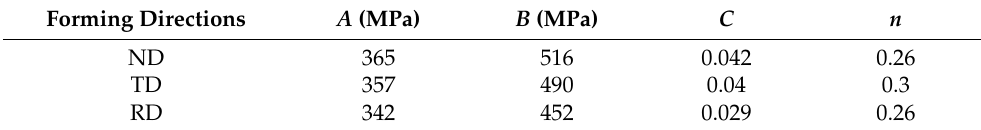
Table 1. Correction values of the JC constitutive parameters A , B , C , and n . Forming